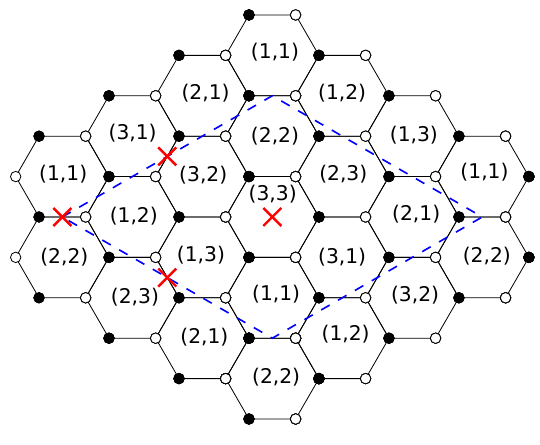
Figure 17 . C 3 = Z